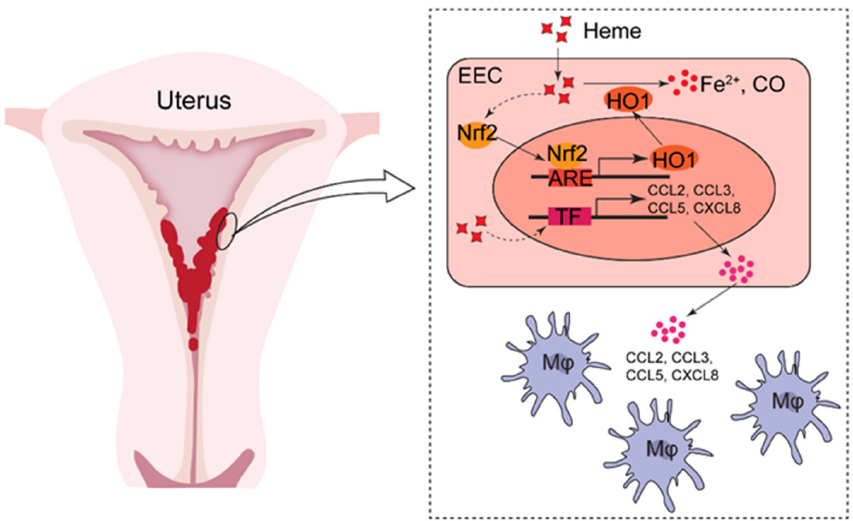
Figure 8. A schematic chart of excess heme in the migration and infiltration of macrophages from AUB patients with EH. In endometria of patients with EH complicated by abnormal uterine bleeding, there should be massive heme release. A certain level of heme activates the Nrf2/HO-1 axis, and further promotes heme metabolism. However, excess heme stimulates EECs to produce more chemokines (e.g., CCL2, CCL3, CCL5), possibly leading to the migration and infiltration of macrophages in the endometrium and accelerating the development of